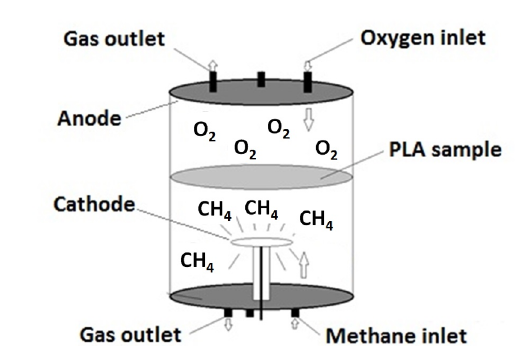
Figure 2. Schematic drawing of the inlet of gas into the plasma reactor system used in the treatment of the PLA samples The plasma was produced at a power of 100 W and a pressure of approximately 1.8 mbar. It was used a duration of 30 minutes of